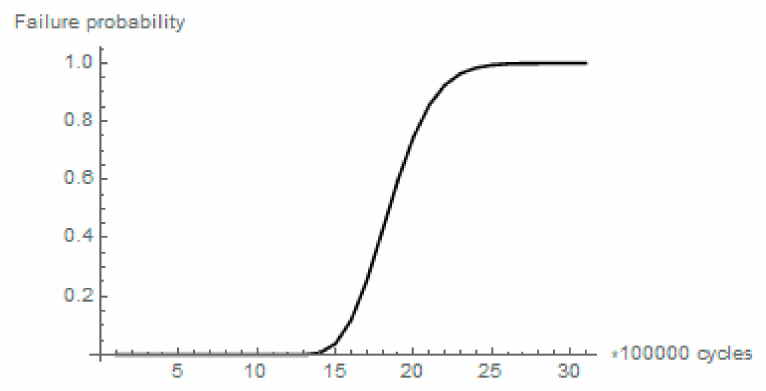
Figure 11. Cumulative probability